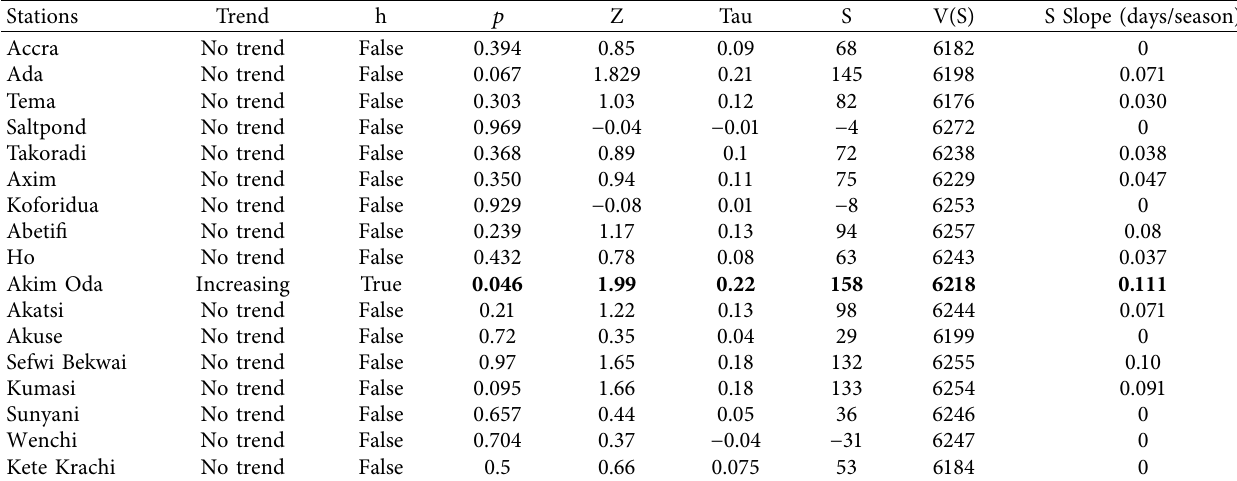
Table 6: Mann-Kendall trend analysis of Heavy Precipitation Days